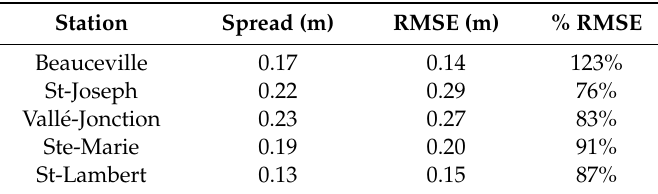
Figure 14. Reliability diagrams of simulation vs. observation probabilities at each control station for the considered parameters flow (Q), roughness coe ffi cients (Rough), a combination of both, and all parameters combined. Table 6. Spread and RMSE at each